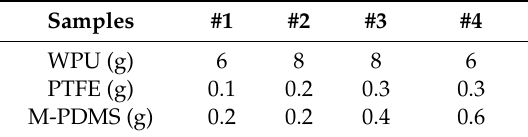
System of the modified polydimethylsiloxane (M-PDMS) / polytetrafluoroethylene (PTFE) / waterborne polyurethane (WPU)